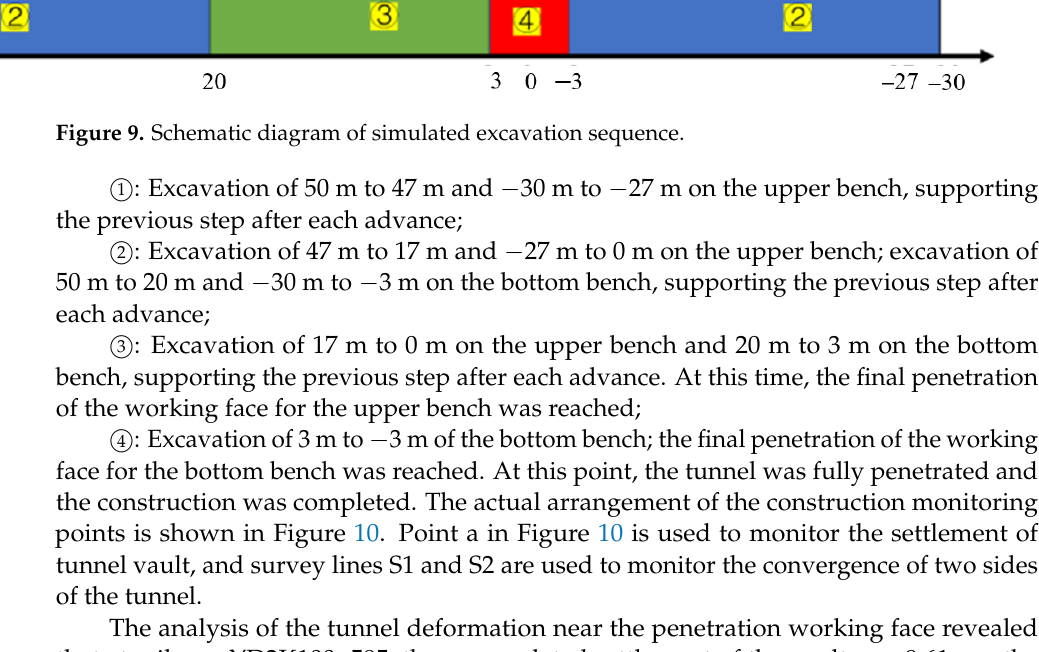
Figure 9. Schematic diagram of simulated excavation sequence.